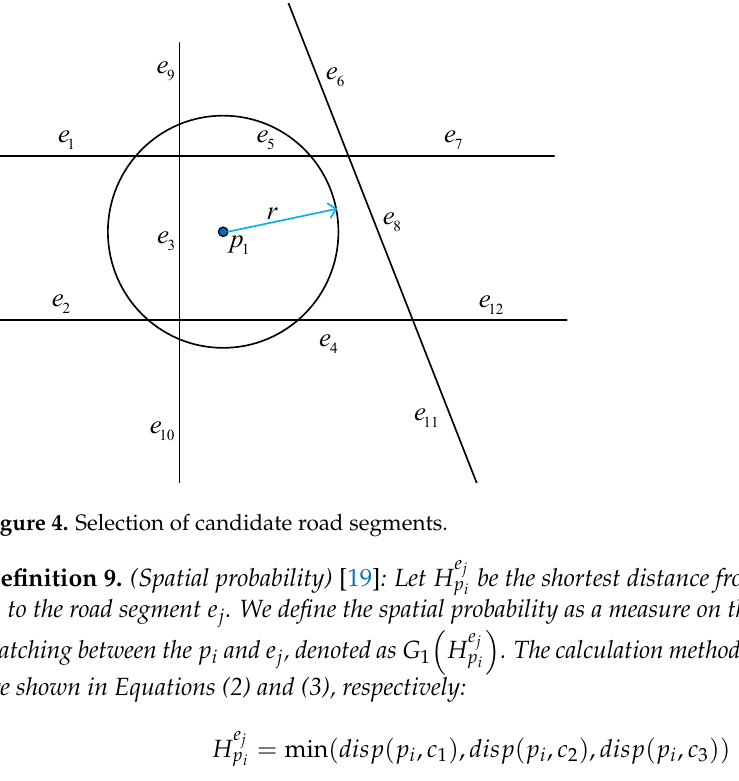
Figure 3. Trajectory segmentation example.